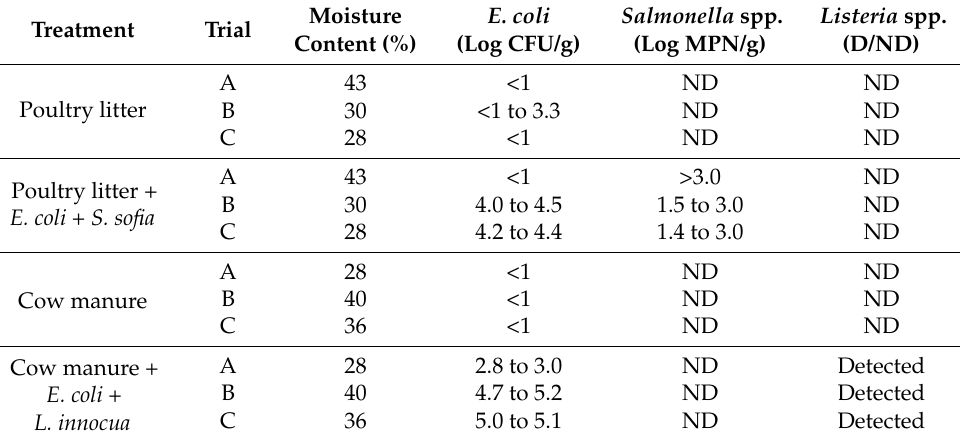
Table 2. Moisture content and microbial populations ( n = 3) in manures before and after inoculation with human pathogens. D/ND indicates detected/not detected. Treatment